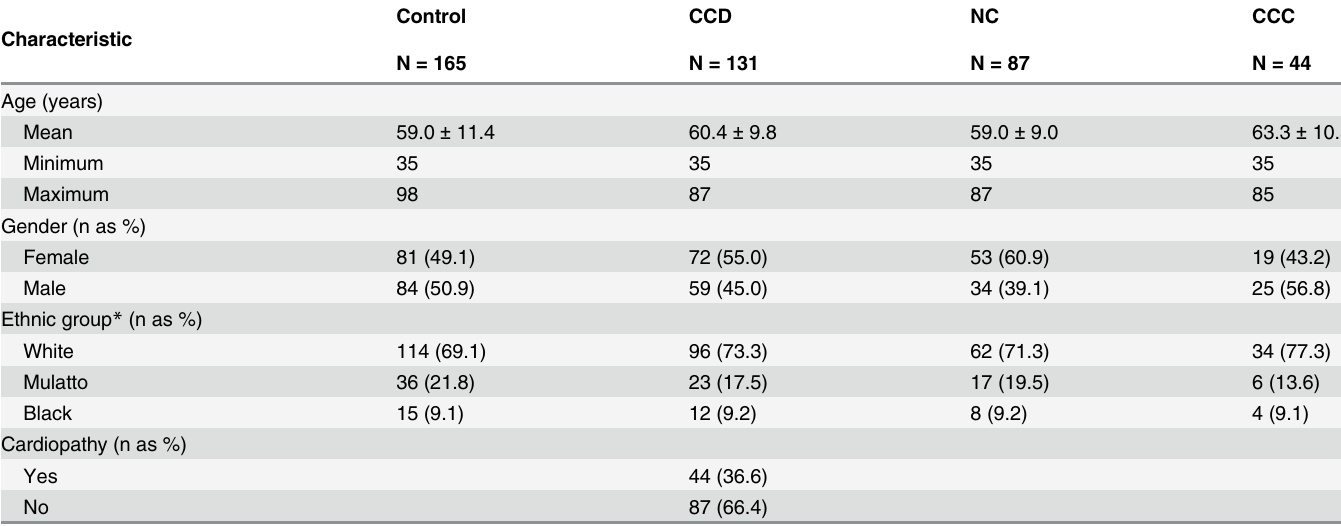
Table 1. Characteristics of the chronic Chagas disease patients and control